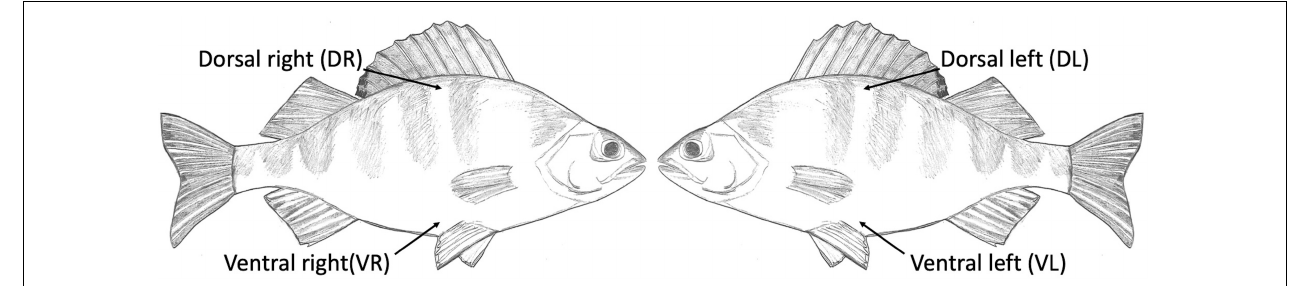
FIGURE 1 | Body sites of Perca fluviatilis that were sampled to characterize variation in skin-associated microbiomes within and among host individuals. Dorsal (D) and ventral (V) samples from right (R) and left (L) side of the body. DR and VR sites were sampled on all 39 individuals included in the study and a subset of these individuals ( n = 16) were also sampled on DL and VL